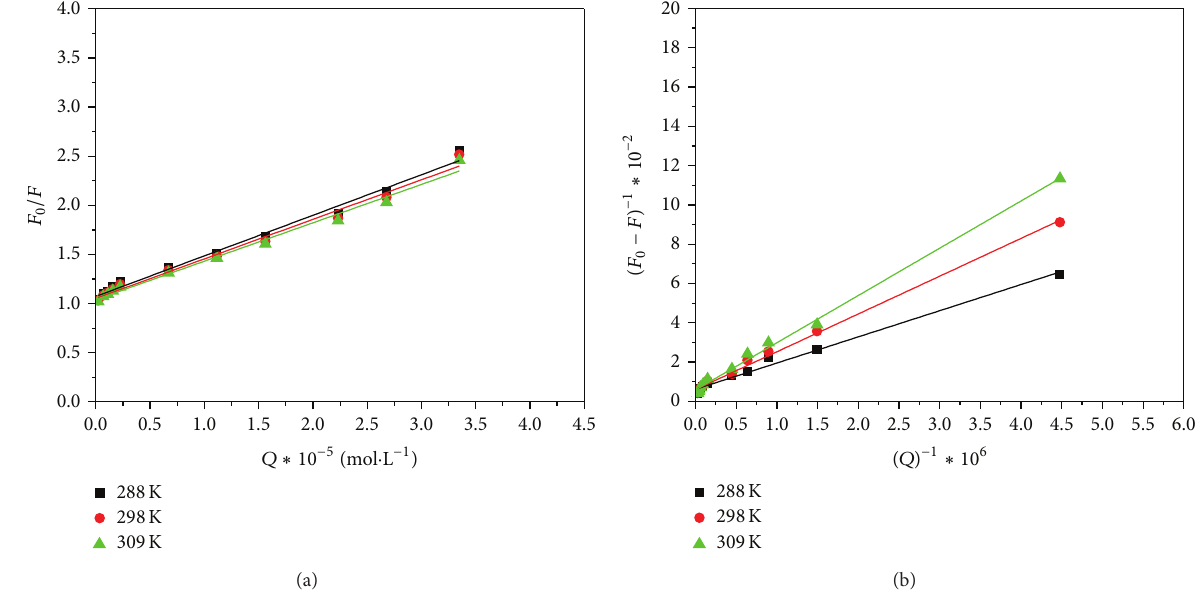
Figure 3: The Stern-Volmer (a) and Lineweaver-Burk (b) curves at different temperatures. Table 1: Stern-Volmer and Lineweaver-Burk correlation parameters for BSA-EVG interaction. ∗ Temperature ( 𝑇 ) Stern-Volmer parameters